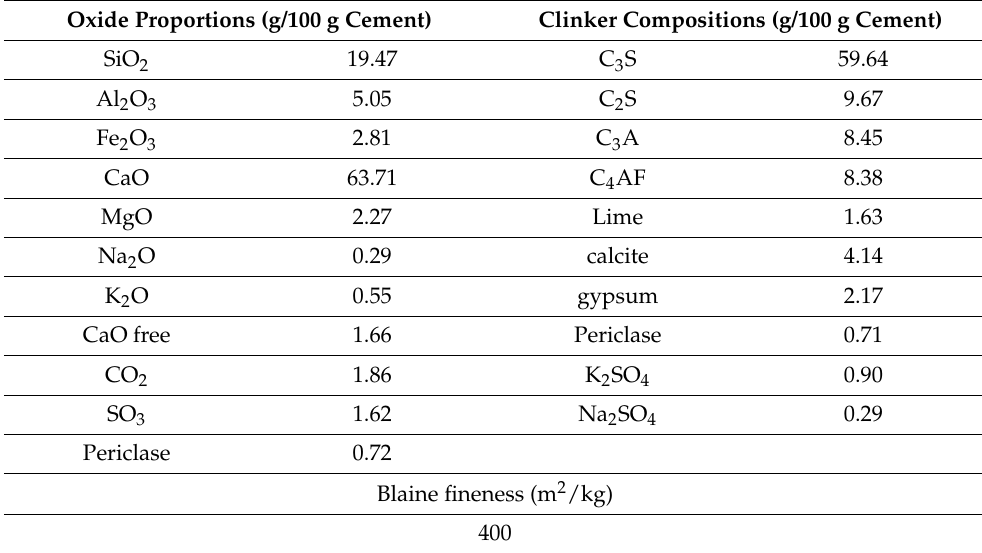
Table 1. Cement oxide proportions and clinker composition (g/100 g